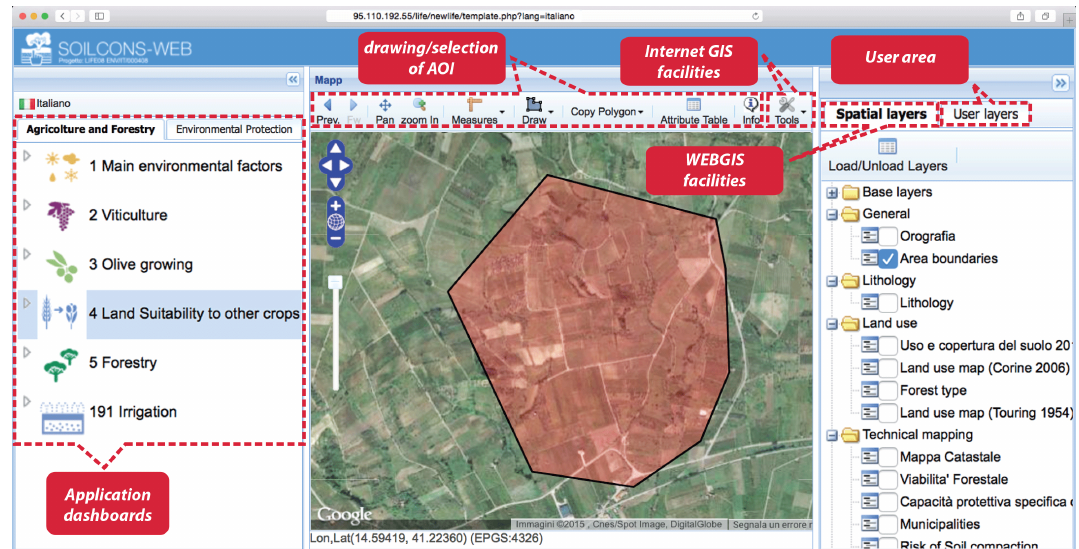
Figure 4. Dashboard design. The user can navigate – in accordance with his needs – by using the five different sections (in red). The individual dashboard tools are written in Italian since the system is, for the moment, aimed toward local Italian communities of